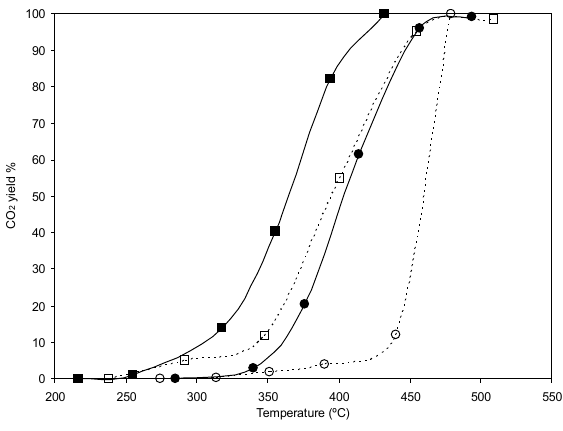
Figure 4: Effect of NOx in the propane combustion, by using RhCoCLI and RhCoCli-Mor. With NO: ■) RhCoCli, ●) RhCoCli-Mor, without NO: □) RhCoCli, ○) RhCoCli-Mor. Reaction conditions: catalyst 0.100 g, total flow 50 mL min -1 , 0 or 1000 ppm NO, 2000 ppm of C O and He to balance. 2